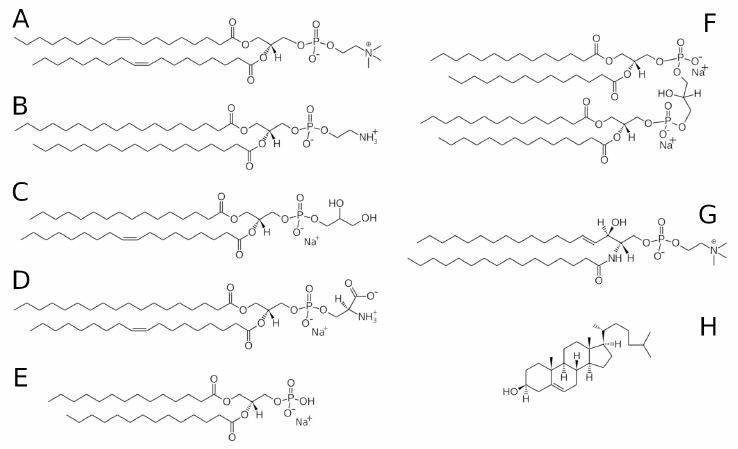
Figure 1. Chemical structures of ( A ) DOPC, ( B ) DSPE, ( C ) POPG, ( D ) SOPS, ( E ) DMPA, ( F ) cardiolipin, ( G ) sphingomyelin, and ( H )